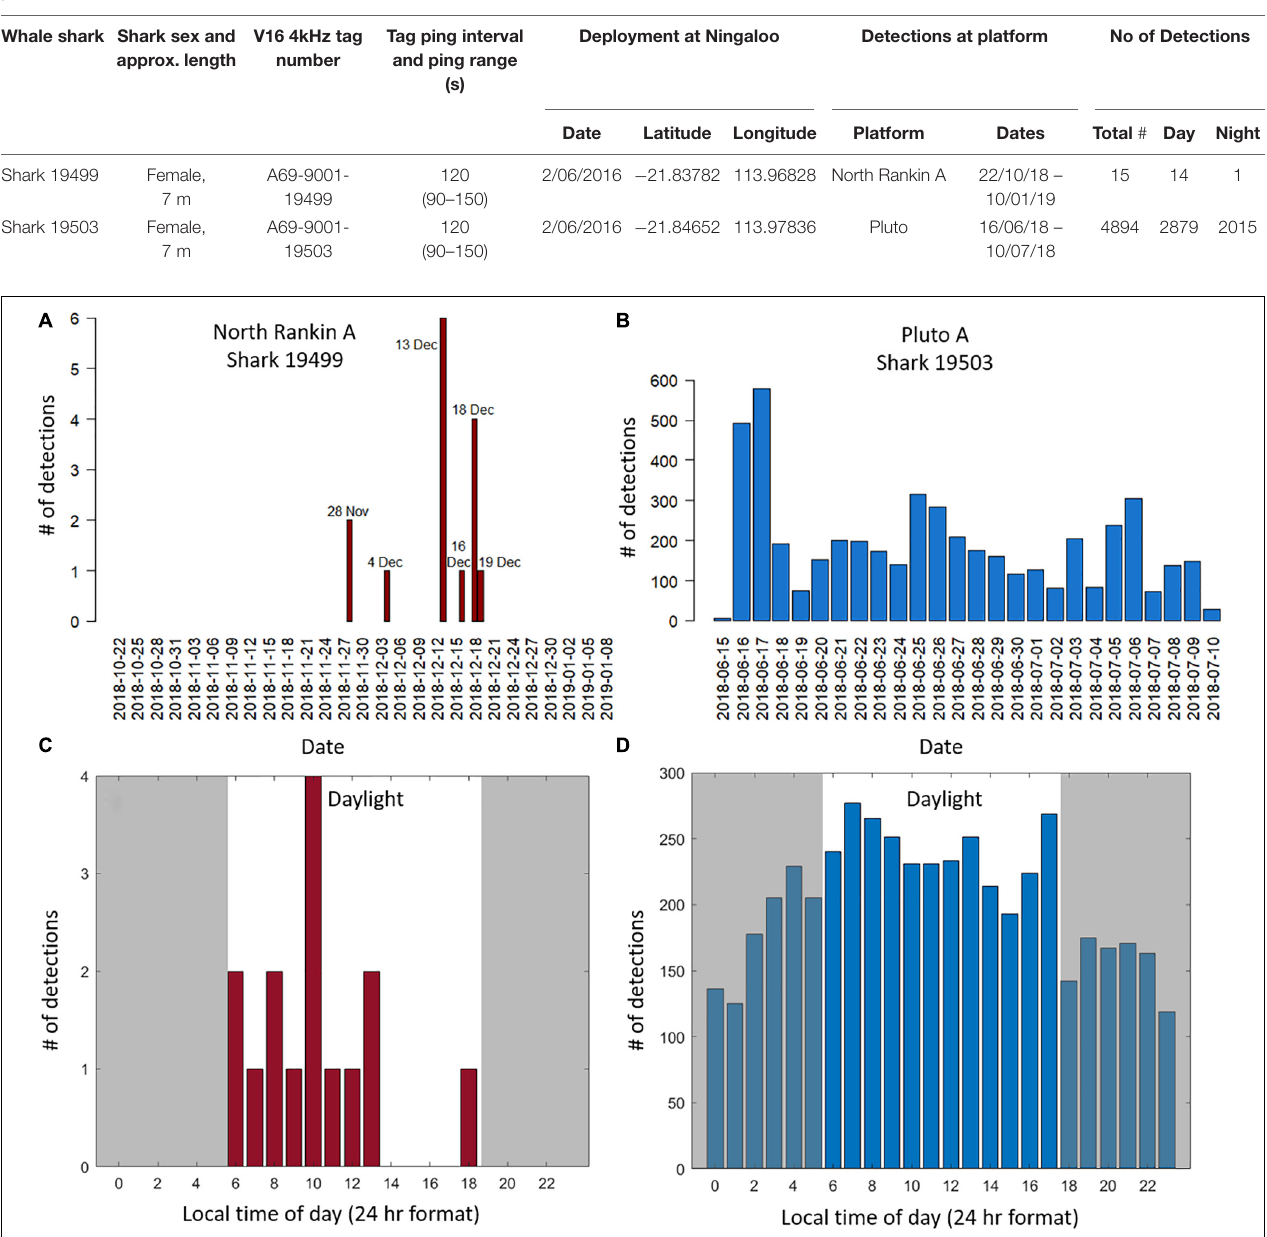
FIGURE 3 | The number of acoustic detections of whale sharks 19499 and 19503 by deployment day [ (A,B) , respectively] and by local hour of day (C,D) at North Rankin A (maroon) and Pluto (blue) platforms, respectively, during the night (shaded) and the day (unshaded). Note the different y -axis scales for detection number on all plots where detections at Pluto were up 100 times those at North Rankin